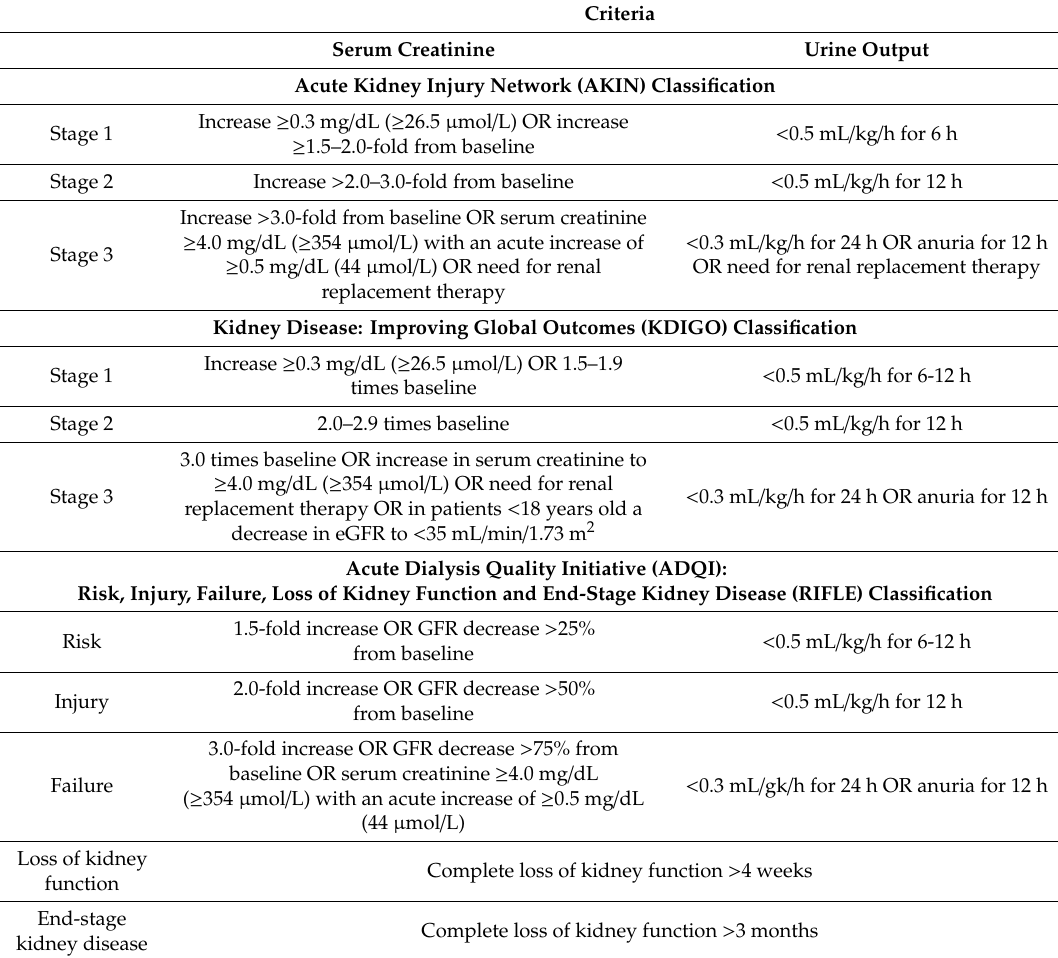
Table 1. Clinical criteria for identifying acute kidney injury and staging the severity of